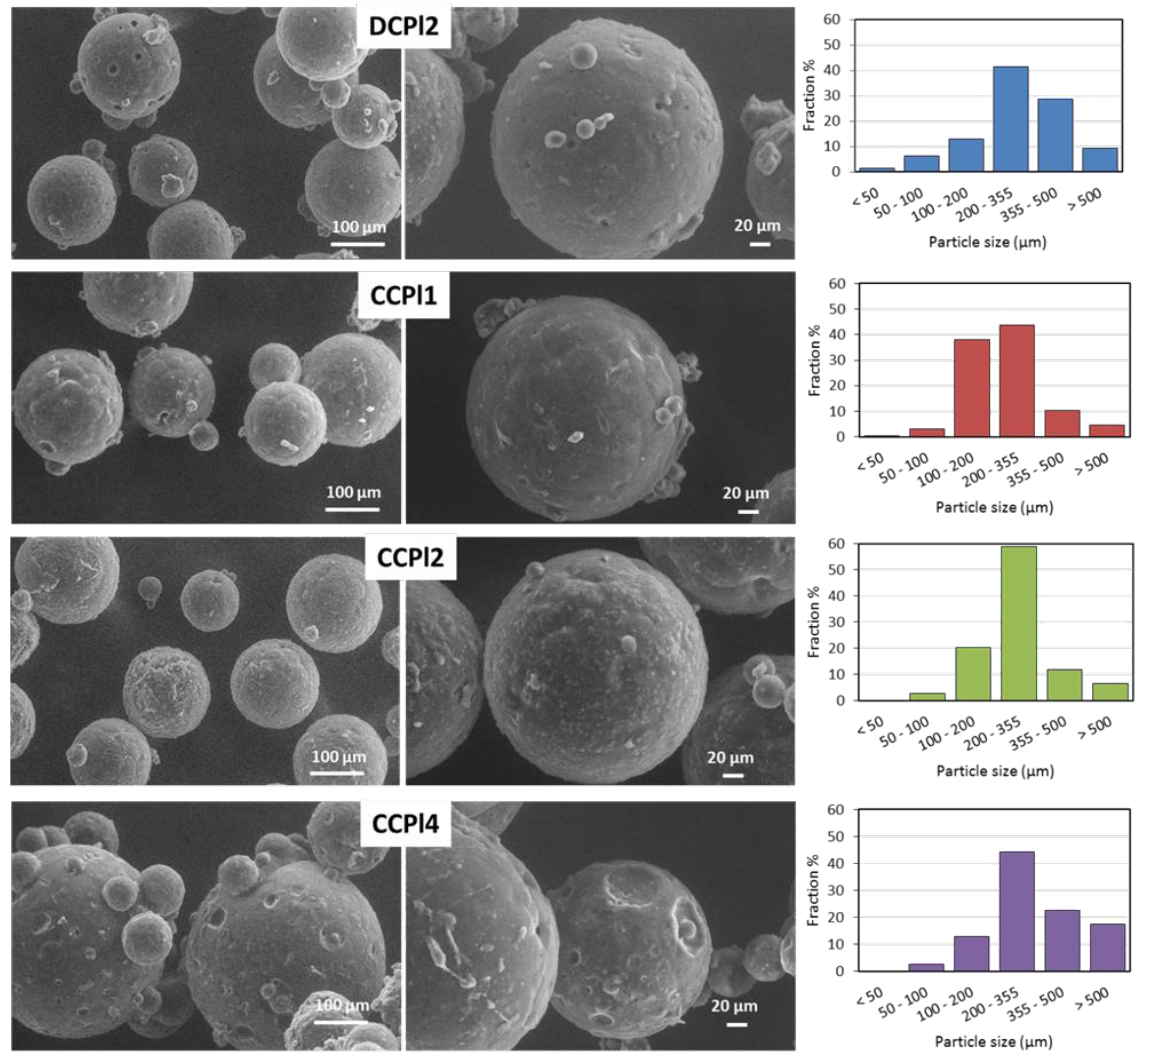
Figure 4. SEM images of DCPl2, CCPL1, CCPl2 and CCPl4 biphasic MPs and their particle size distribution.